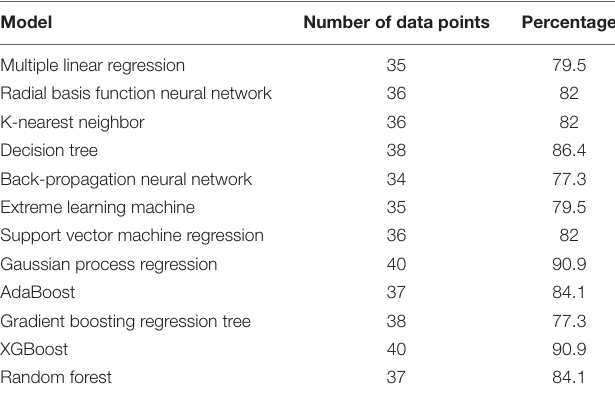
TABLE 3 | Statistics for the amount of monthly data in each model deviation within ± 2. Model